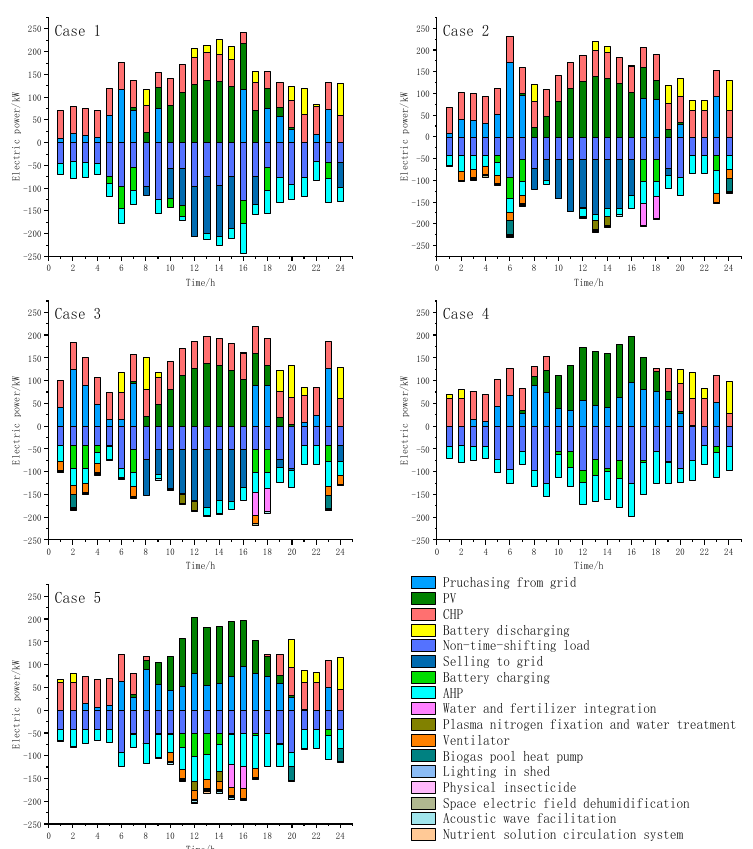
Figure 7. The result of optimal dispatch of electric power in five cases.